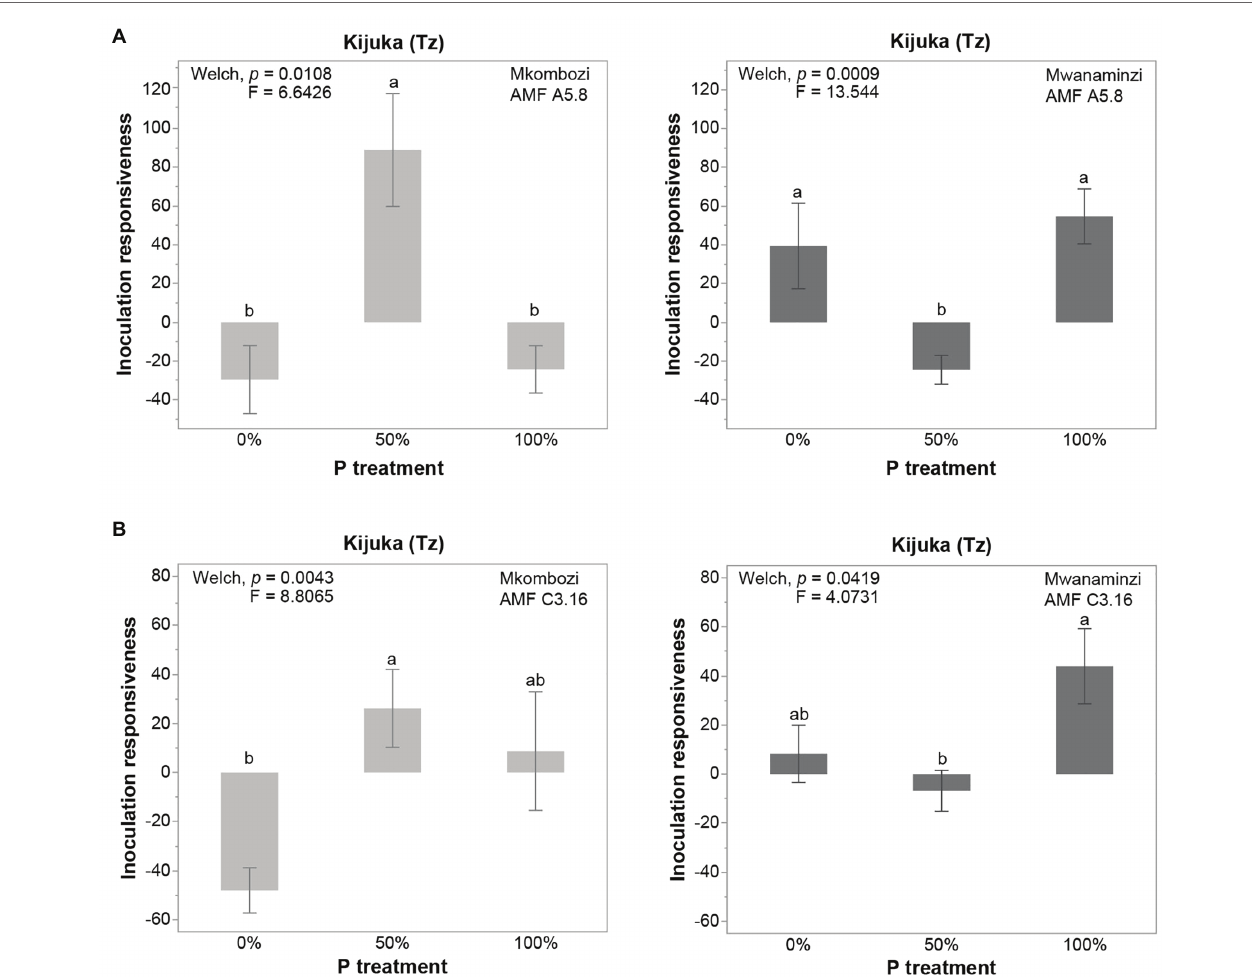
FIGURE 4 | Inoculation responsiveness of Mkombozi and Mwanaminzi varieties to inoculation with Rhizophagus irregularis (A) culture A5.8 and (B) culture C3.16, subjected to different P fertilization treatments at Kijuka. Error bars represent ±SE. Means with different letters are significantly different at p < 0.05 according to a Games-Howell post hoc test. Tz, Tanzania. Inoculation responsiveness was calculated by comparing inoculated plants to non-inoculated